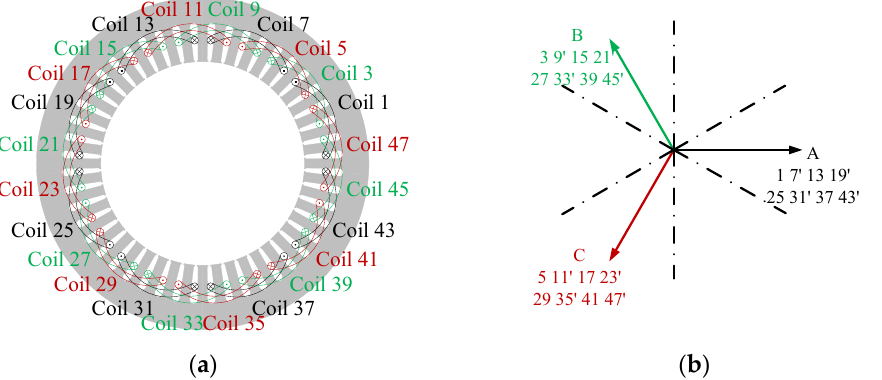
Figure 2. Winding arrangements of Toyota Prius 2010 IPM machine: ( a ) winding layouts; ( b ) coil EMF phasor diagram.